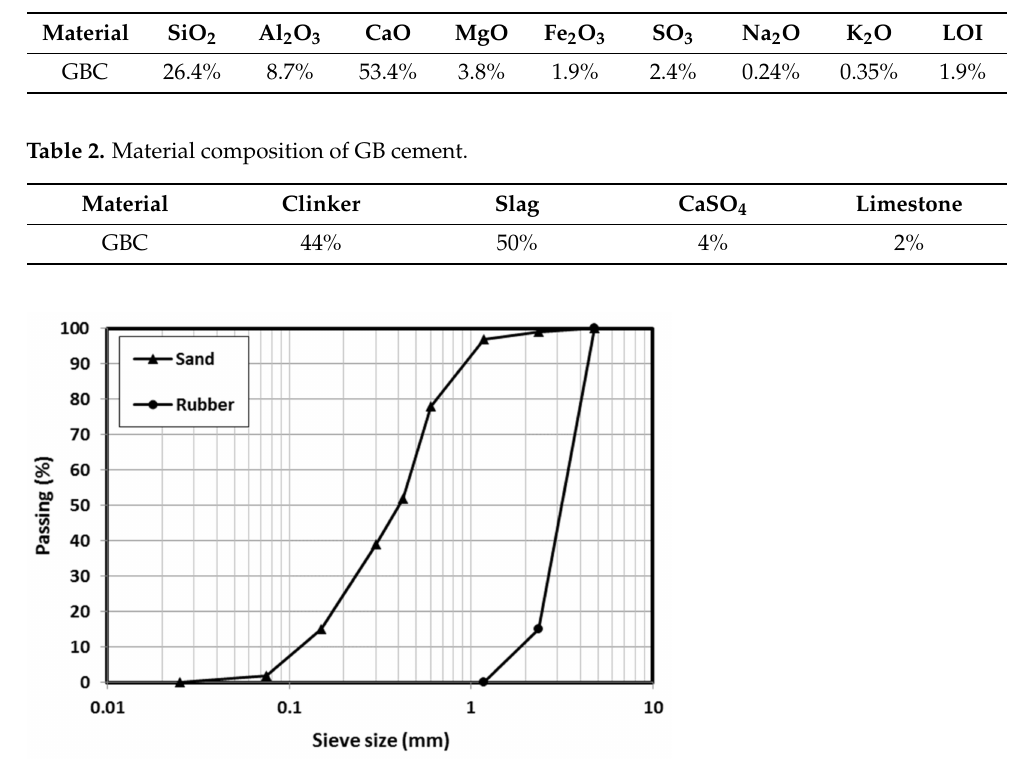
Figure 1. Sieve analysis of sand and rubber